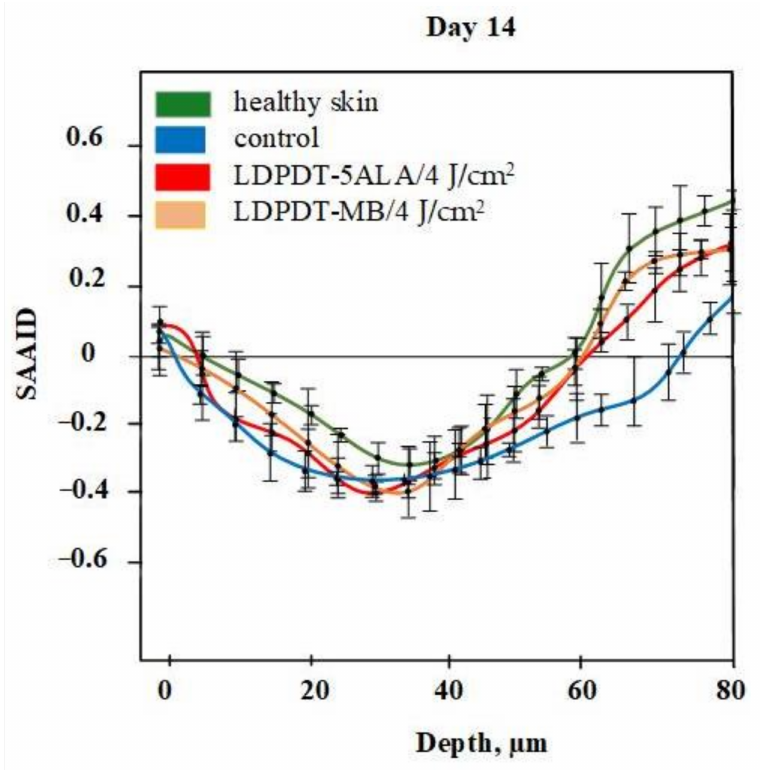
Figure 9. SAAID for LDPDT–5-ALA and LDPDT–MB/4 J/cm 2 groups.